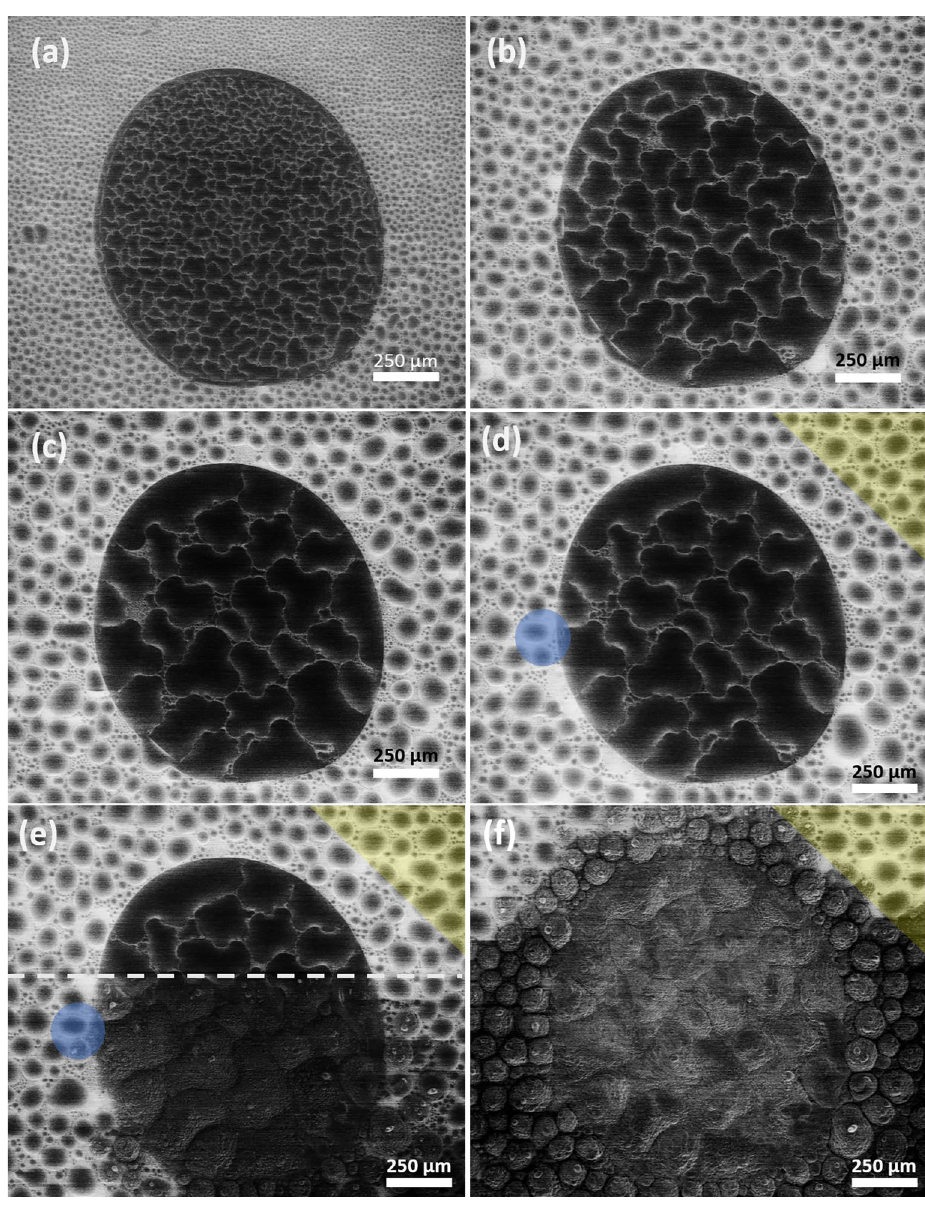
Figure 8. ( a – d ) SCW droplets on an apoferritin spot and on the copper substrate. ( a ) t = 0 s and P = 131 Pa. ( b ) t = 2 s and P = 134 Pa. ( c ) t = 5 s and P = 129 Pa. ( d ) t = 8 s and P = 129 Pa. ( d – f ) Crystallization process of SCW. The yellow triangle shows SCW droplets that remain liquid during the crystallization process. The blue disk marks an ice bridging event during freezing front movement. ( e ) t = 9 s and P = 129 Pa. During the scan, SCW crystallizes rapidly (dashed line) on the apoferritin spot and on some parts of the copper substrate. ( f ) t = 10 s and P = 129 Pa. Modified with PowerPoint (www. micro soft. com/ es- es/ micro soft- 365/ power